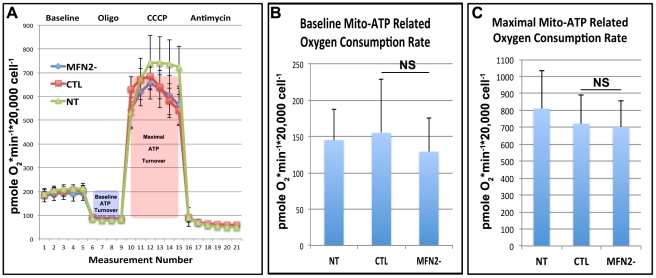
Effect of MFN2 deficiency on oxygen consumption rate (OCR) profile.(A) Serial measurements of OCR at 7 minute intervals (“measurement number”) in MFN2-deficienct (MFN2-) and control (empty virus transduced “CTL” or non-transduced; “NT”) cells at baseline and after the addition of oligomyin, CCCP, or antimycin. Results of a single representative study with five replicate OCR measurements and their SD is shown. (B) OCR due to baseline ATP turnover rate (baseline minus oligomycin OCR) in each group expressed as the mean and SD of 3 separate experiments; NS “non significant; P>0.05. (C) OCR due to maximal mitochondrial ATP turnover rate (CCCP stimulated minus oligomycin OCR) in each group expressed as the mean and SD of 3 separate experiments; NS “non significant; P>0.05.